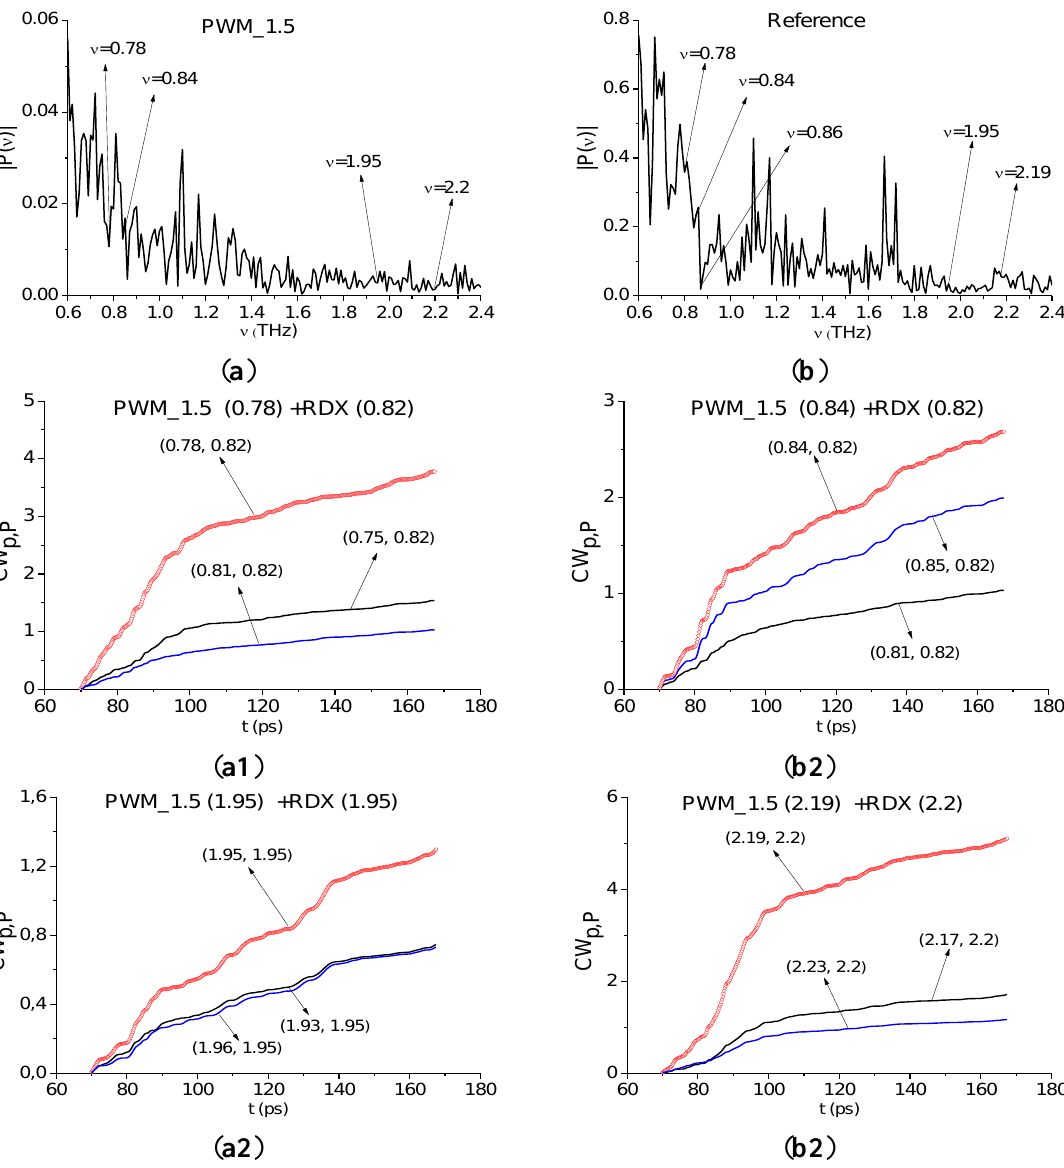
Figure 25. Fourier spectrum of the remote part of the PWM_1.5 signal ( a ) and Reference signal spectrum ( b ) in the frequency range ν = [0.6, 2.4] THz; integral characteristics CW p , P ( t n ) detecting the frequencies ν = 0.78 THz ( a1 ); 0.84 THz ( b1 ); 1.95 THz ( a2 ); 2.19 THz ( b2